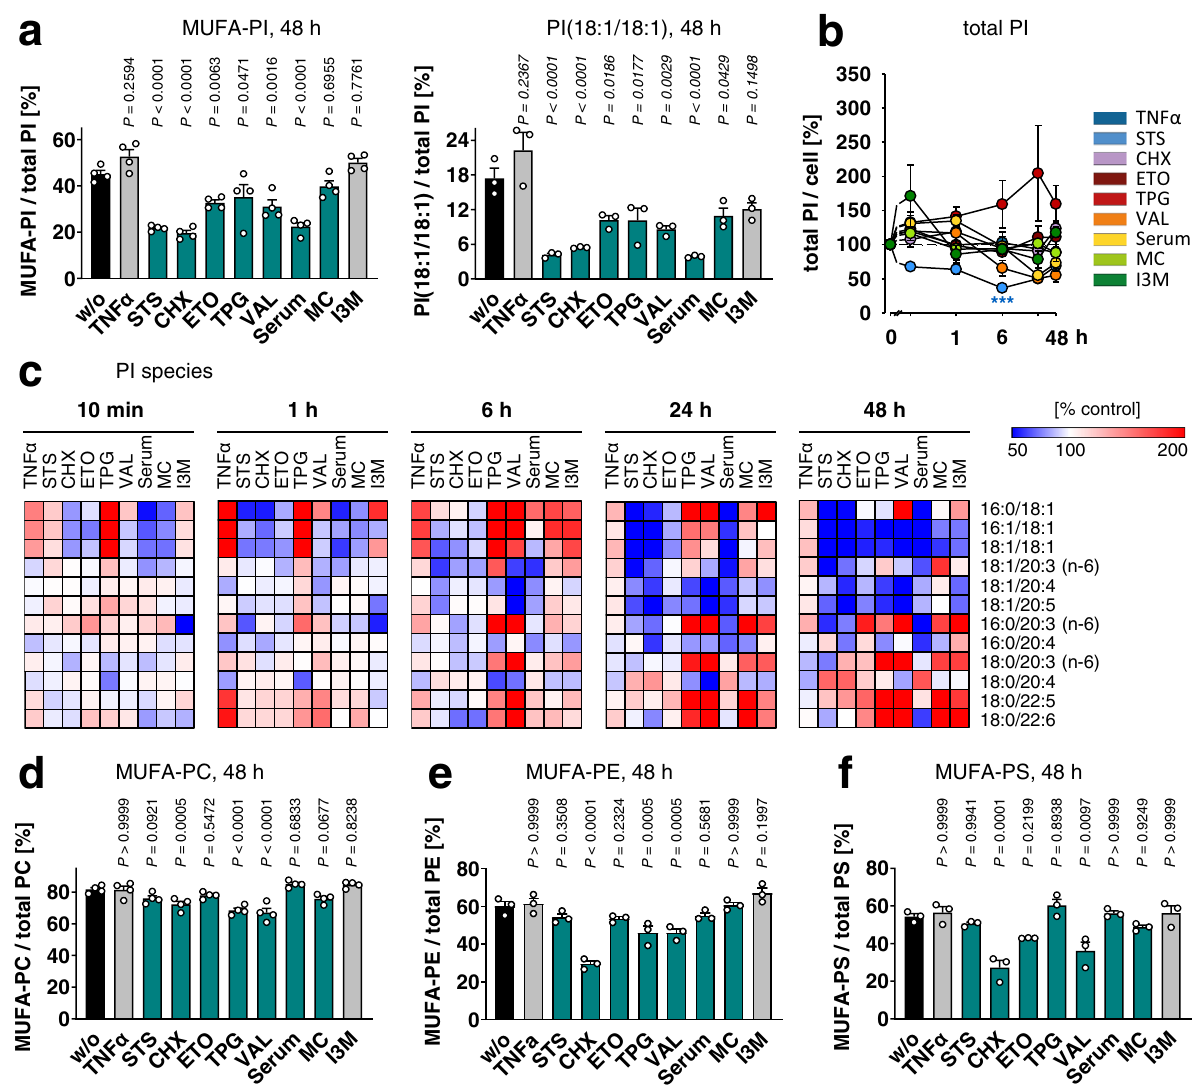
Fig. 1 Programmed cell death decreases the cellular proportion of MUFAs in PI. NIH-3T3 fi broblasts were treated with vehicle, TNF α (10 ng/ml), STS (0.3 µ M), CHX (20 µ g/ml), ETO (10 µ M), TPG (2 µ M), VAL (10 µ M), MC (10 µ M), or I3M (10 µ M) or were serum starved (Serum) for the indicated period of time. a , d – f Cellular proportion of MUFAs in PI and PI(18:1/18:1) (left to right (LTR) P = 0.0000004, 0.00000007, 0.0000007) ( a ), PC (LTR P = 0.9999999986, 0.000002, 0.0000003) ( d ), PE (LTR P = 0.99991, 0.000000007, 0.99999992) ( e ), and PS (LTR P = 0.99992, 0.99998, 0.99997) ( f ); MUFAs: 16:1, 18:1. Data of ( a ), ( d ) is identical to w/o in Supplementary Figs. 13a and 16c, d. b Time-dependent changes of the cellular PI content. c Heatmap showing the time-dependent changes of the cellular PI pro fi le ( P = 0.0007). Data are given as percentage of vehicle control for each time point. Mean ( c ) or mean + s.e.m. ( b ) and single data ( a , d – f ) from n = 3 ( a right panel, b , c , e , f ), n = 4 ( a left panel, d ) independent experiments. *** P < 0.001 for the respective time point ( b ) or P values given vs. vehicle control ( a , d – f ); repeated measures one-way ANOVA ( a , d – f ) of log data ( b ) + Tukey HSD post hoc Lipidomic analysis suggests that PUFAs and MUFAs are and then experienced an even stronger boost in activation up to 48 h redistributed during the initiation of cell death. Thus, PI(palmitic (Fig. 2b, c). This second phase of p38 MAPK phosphorylation has acid (16:0)/18:1), PI(16:1/18:1), and PI(18:1/18:1) are enriched for similar kinetics to the decrease of the cellular MUFA-PI ratios multiple cytotoxic stressors 6 h post cell death induction before (Fig. 1c and Supplementary Fig. 1b, c). Both effects manifested the depletion of MUFAs becomes dominating (Fig. 1c). between 6 to 48 h of treatment and were time-dependently enhanced. Since STS is a pan-kinase inhibitor 43 , we did not fur- ther consider its effect on kinase phosphorylation, although p-p38 Cytotoxic drop in MUFA-PI correlates with active p38 MAPK . MAPK levels were elevated as expected. Substantial activation of We investigated whether death-induced changes in the phospholipid JNK, another major stress-activated kinase, was only evident for pro fi le are associated with the regulation of stress-activated kinases. TPG and MC (Fig. 2d), which suggests that the global negative In particular, phospholipids from the MUFA-rich cluster showed a correlation of MUFA-PI is p38 MAPK speci fi c. negative correlation to p38 MAPK phosphorylation (Fig. 2a) in line To further investigate whether MUFA-PI ratios and p38 with previous studies that addressed ER stress and cell cycle M/G1 MAPK activation correlate during cell death in other cell lines, we transition 29 . p38 MAPK was rapidly activated within 10 min to 6 h